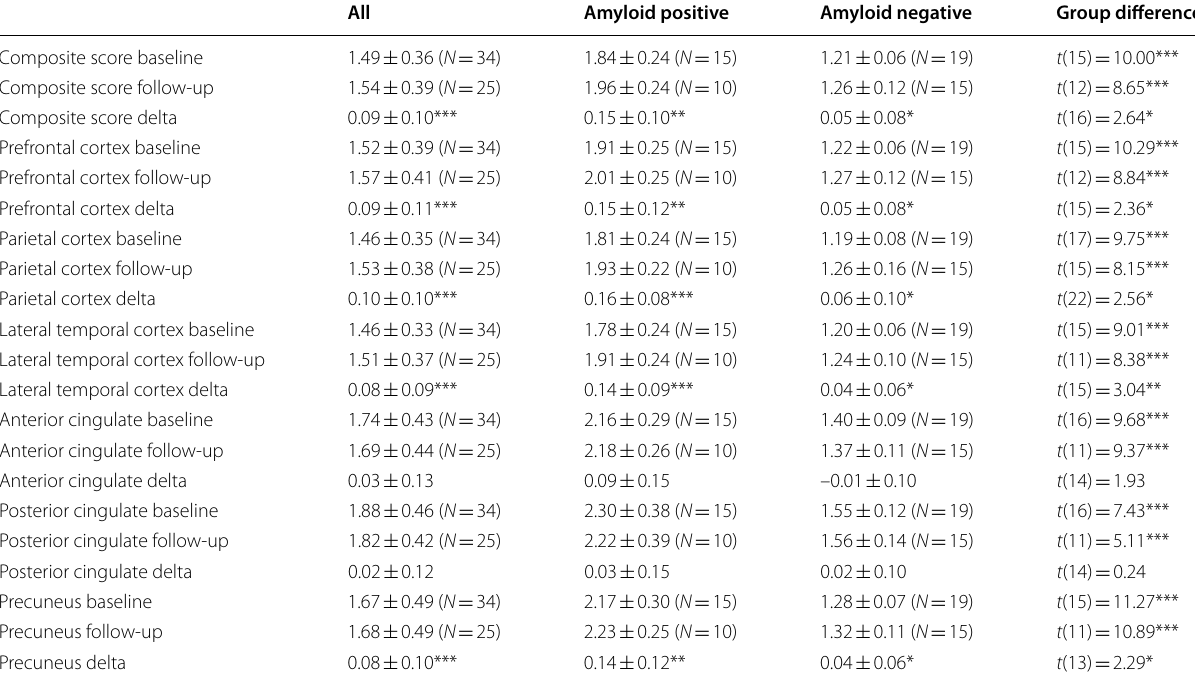
Stars denote significance levels in paired t test between baseline and follow-up measures: * p < 0.05, ** p < 0.01, *** p < 0.00